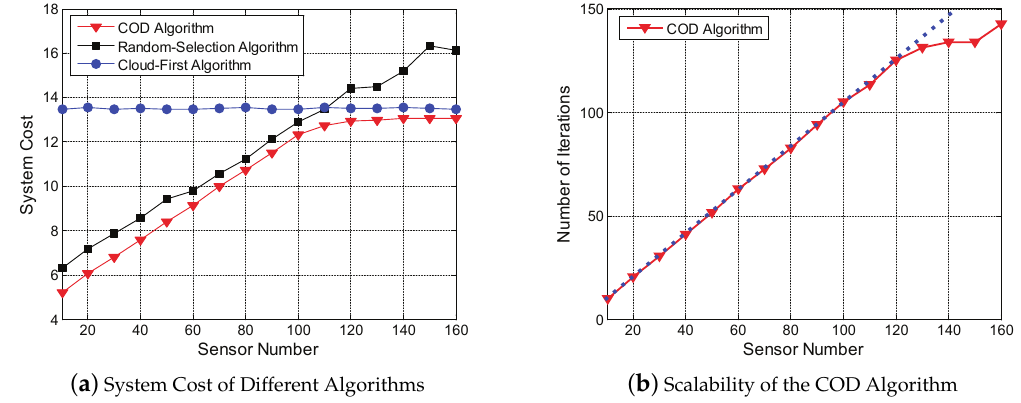
Figure 2. Performance of the COD Algorithm.